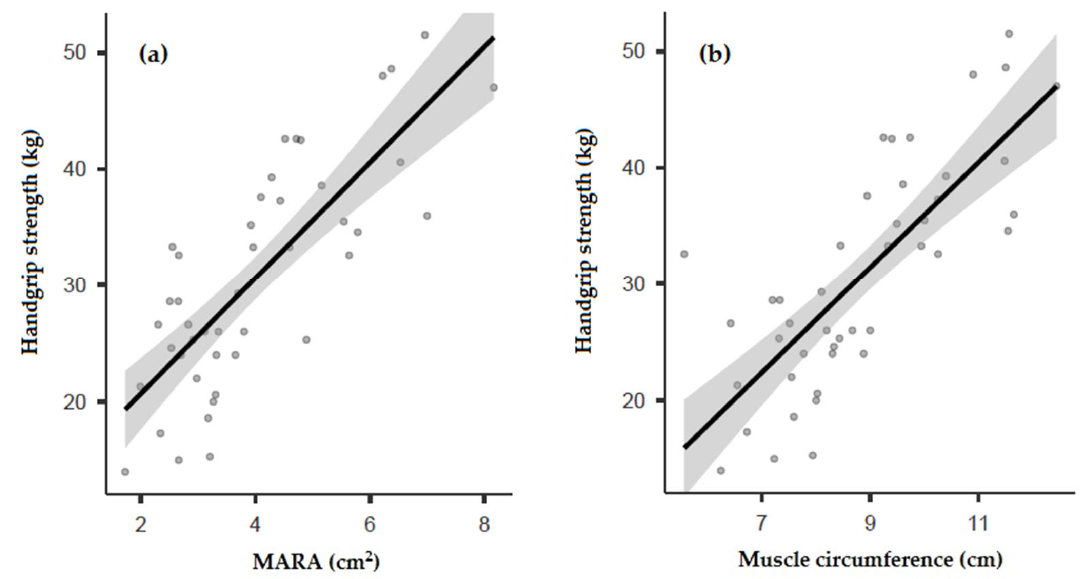
Figure 2. Correlation of handgrip strength with MARA ( a ) and muscle circumference ( b ). MARA: